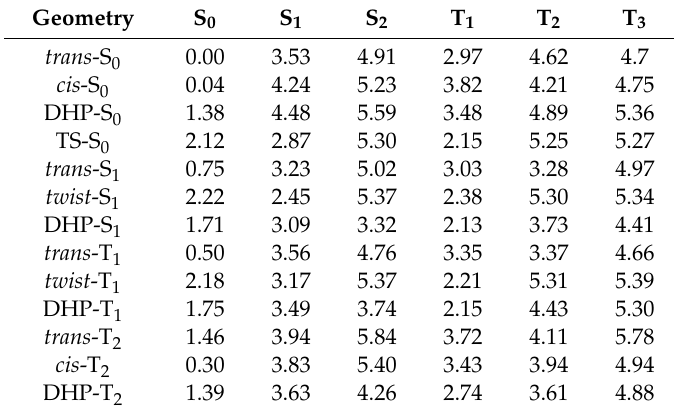
Table 3. The relative potential energies (in eV) calculated by MS-NEVPT2 method for the trans -, cis -, twist -, TS-DANS and DHP optimized by SA6-CASSCF (18,12).